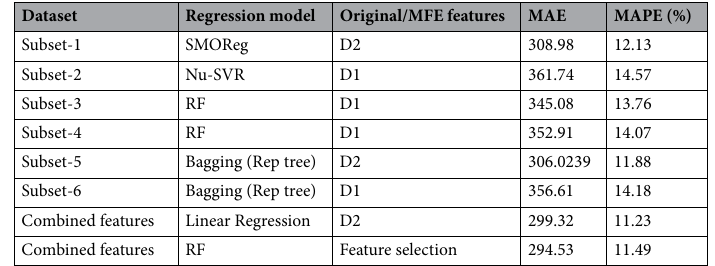
Table 3. Summary of the best results across all the